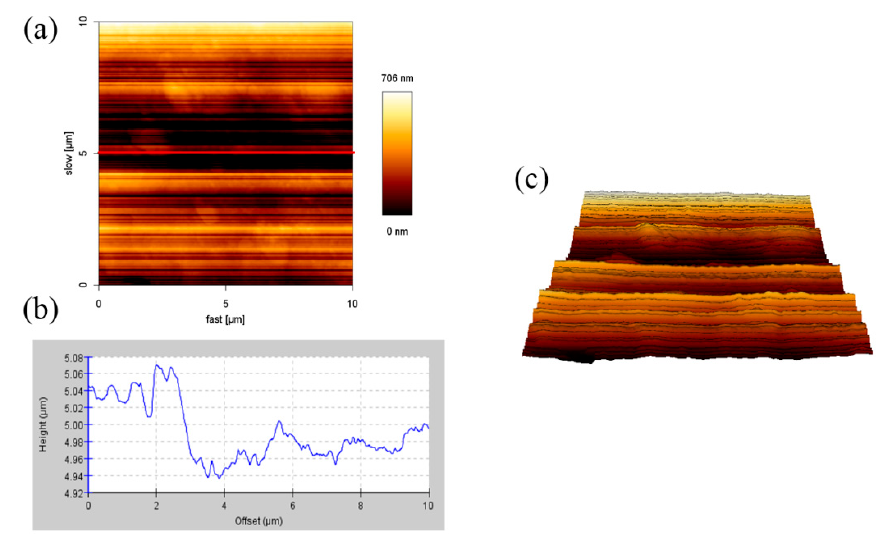
Figure 1. Atomic force microscope (AFM) images (10 × 10 µm) of 1% SiO 2 monolayer films: ( a ) A height image; ( b ) cross-section height profiles along the line in ( a ), and ( c ) a 3D reconstruction image.